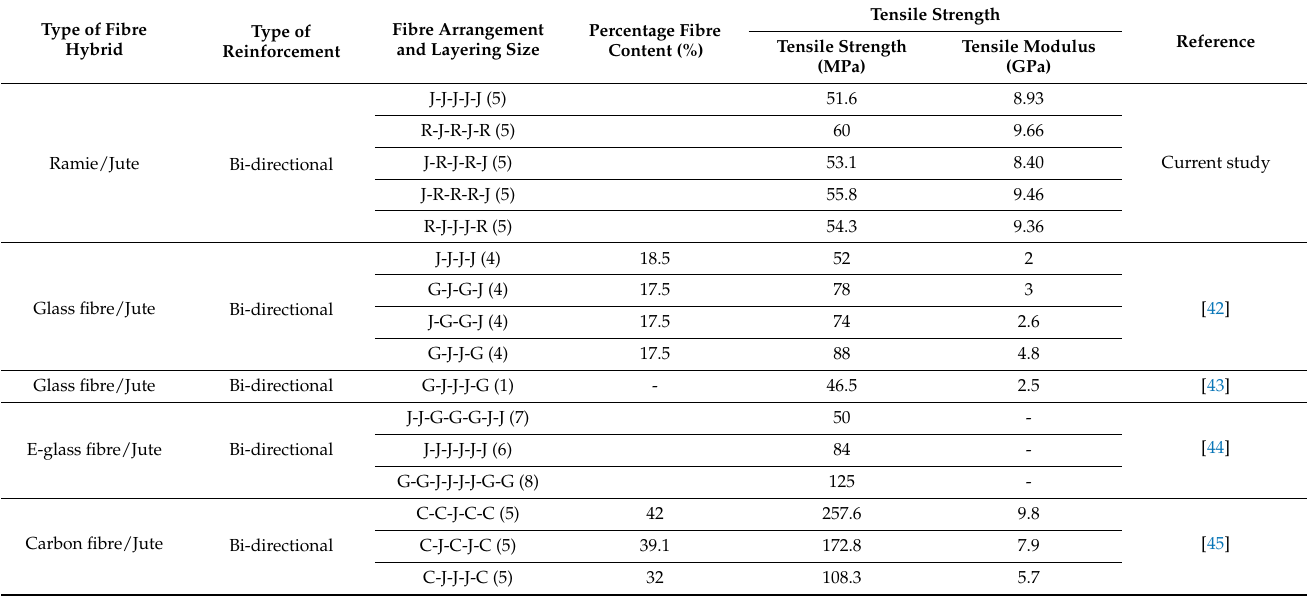
Table 3. Comparison of tensile properties of the hybrid reinforced epoxy composite.